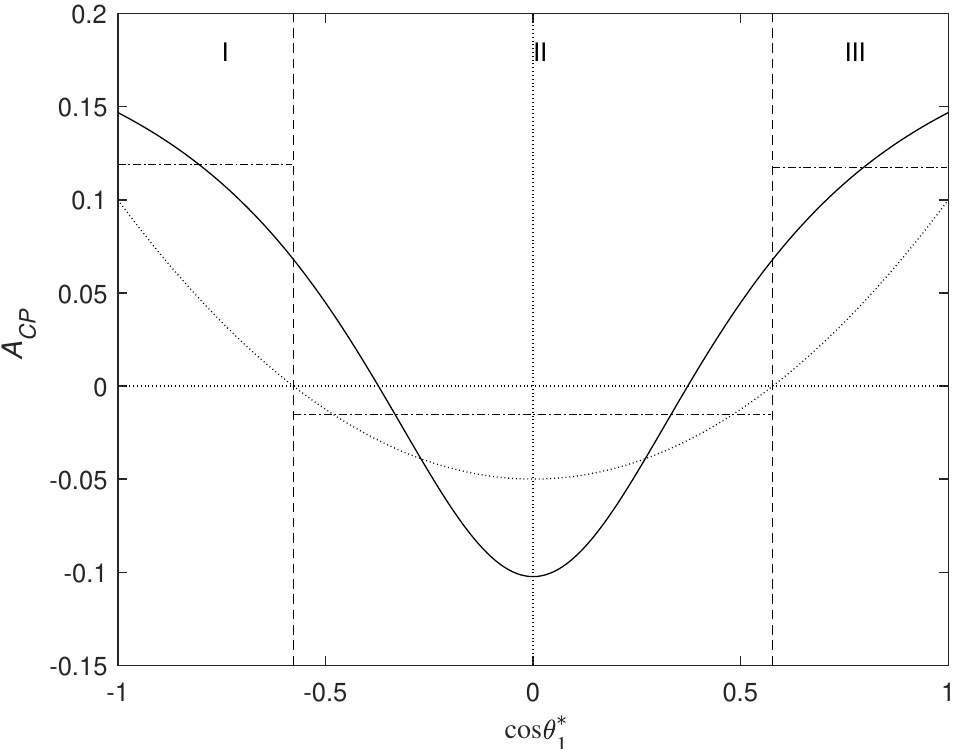
Figure 2 . Differential CP A for δ = 4 (solid line), r CP As of the region I, II, and III (dash-dotted line in each region), are shown as a function of c θ ∗ shown with dotted